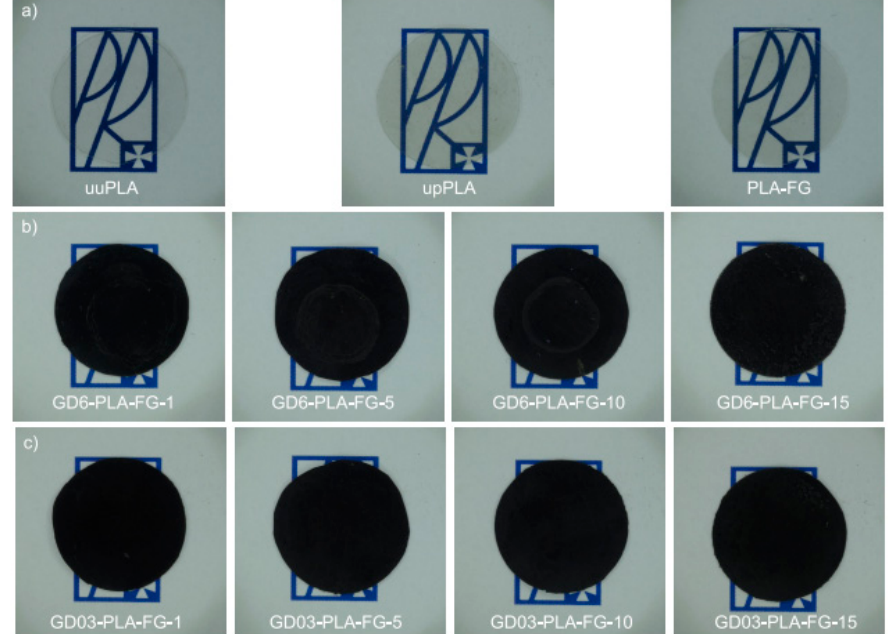
Figure 1. The pictures of ( a ) PLA; ( b ) graphite/diamond with 6 wt.% ash content PLA nanocomposites, and ( c ) graphite/diamond with 0.3 wt.% ash content PLA nanocomposites of various nanofiller contents. uuPLA—unfilled and unprocessed PLA; upPLA—unfilled and processed PLA; PLA-FG—PLA with plasticizer and compatibilizer; GD6—graphite/diamond mixture with 6 wt.% ash content; GD03—graphite/diamond mixture with 0.3 wt% ash content; numbers—wt.% of filler (GD6,